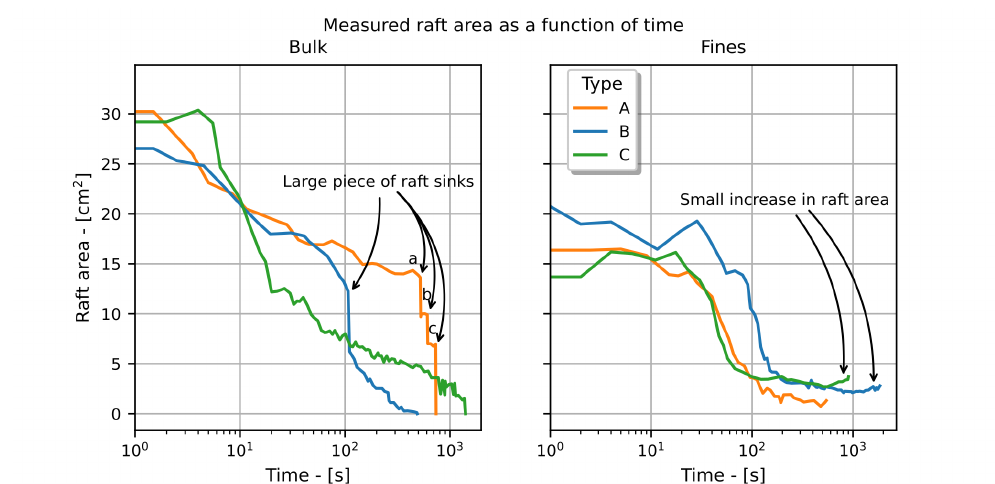
Figure 10. Measured raft area as a function of time, where a, b and c denotes sinking of rafts pieces, which can be seen more detailed in Figure 11.